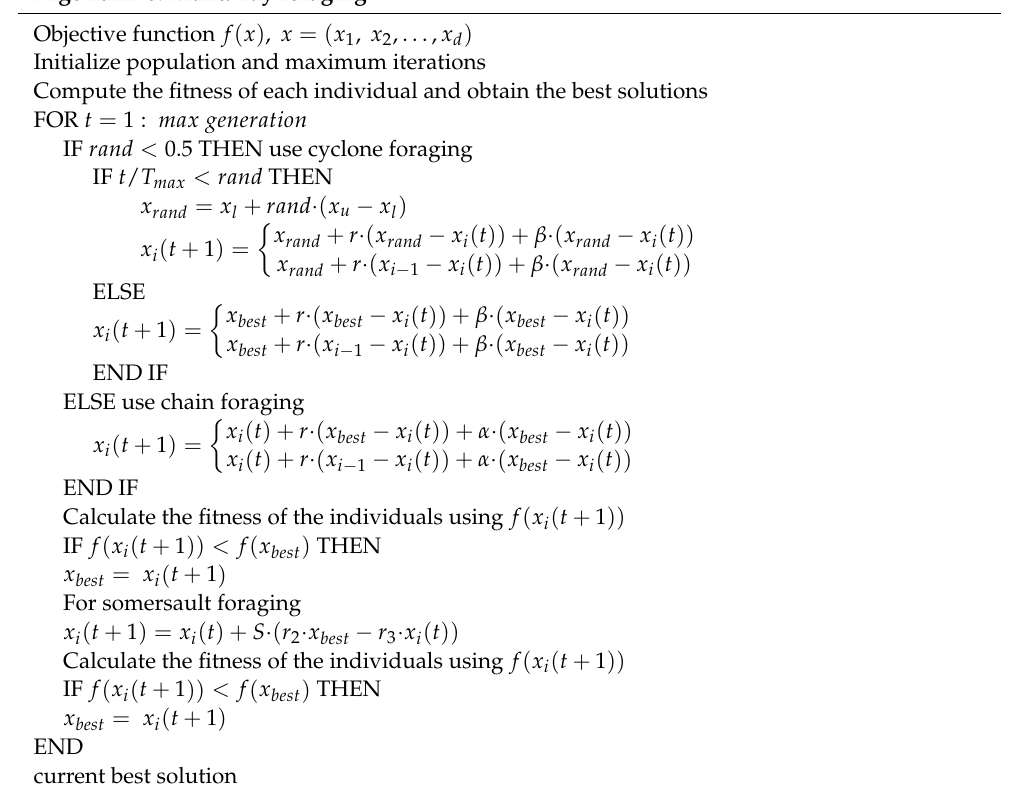
Algorithm 8: Manta ray foraging